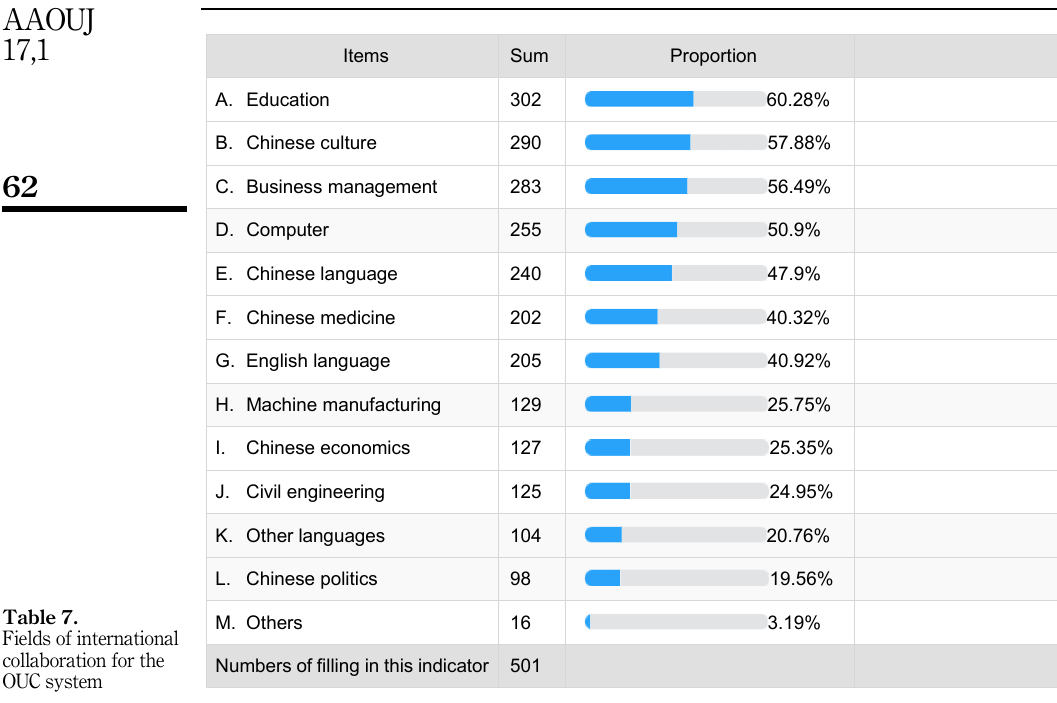
collaboration for the OUC